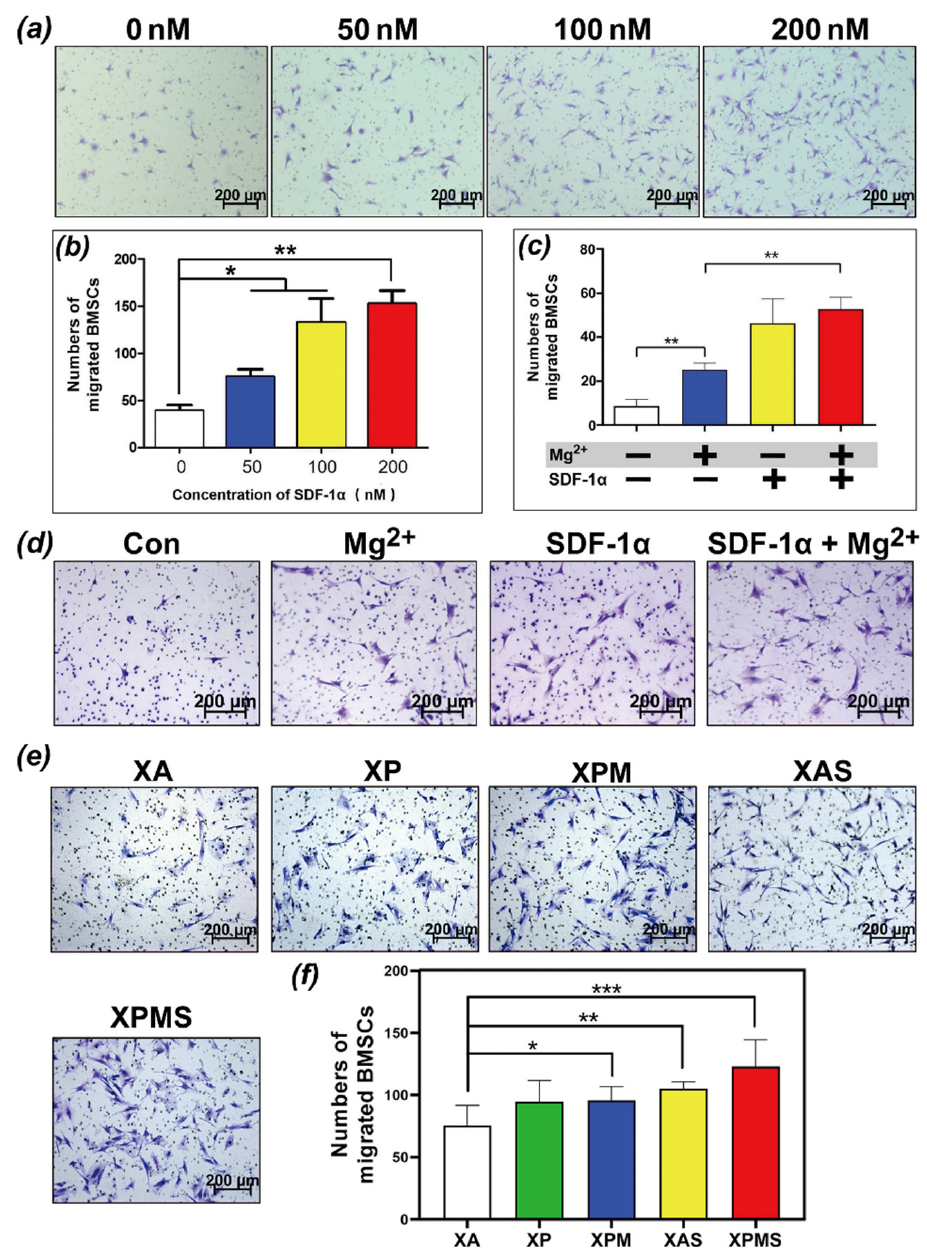
Figure 2. In vitro effect of SDF-1 α loaded hydrogels on recruiting BMSCs; ( a , b ) the mobility and migration of BMSCs stimulated by different concentrations of SDF-1 α were evaluated; ( c , d ) the synergistic chemotactic effect of SDF-1 α and Mg 2+ were evaluated; ( e , f ) The chemotactic effect of SDF-1 α released from hydrogels were evaluated; * p < 0.05, ** p < 0.01, and *** p < 0.001.